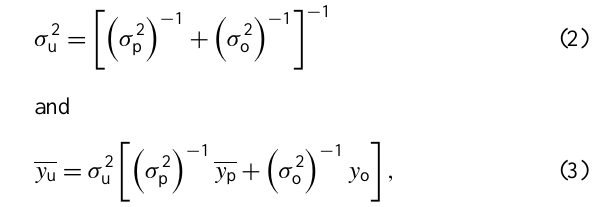
Figure 2. Schematic representation of the data assimilation and state update procedures in the Data Assimilation Research Testbed (DART) used in this study. Adapted from original DART diagram available at